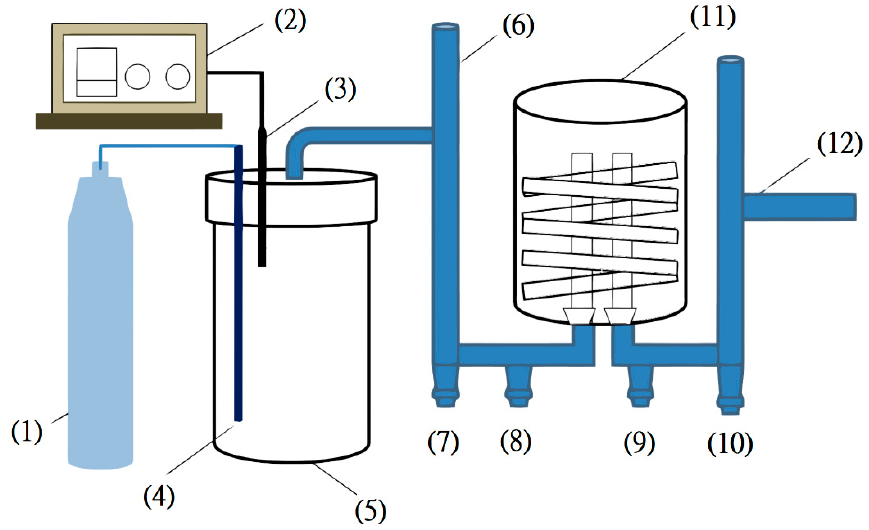
Figure 1. Schematic diagram of the heat-treated equipment. (1) N 2 cylinder, (2) Controller, (3) Thermocouple, (4) Air supply tube, (5) Heat-treated body, (6) Condenser, (7~10) Liquid-collecting vessels, (11) Water cooling tower, (12) Exhauster.